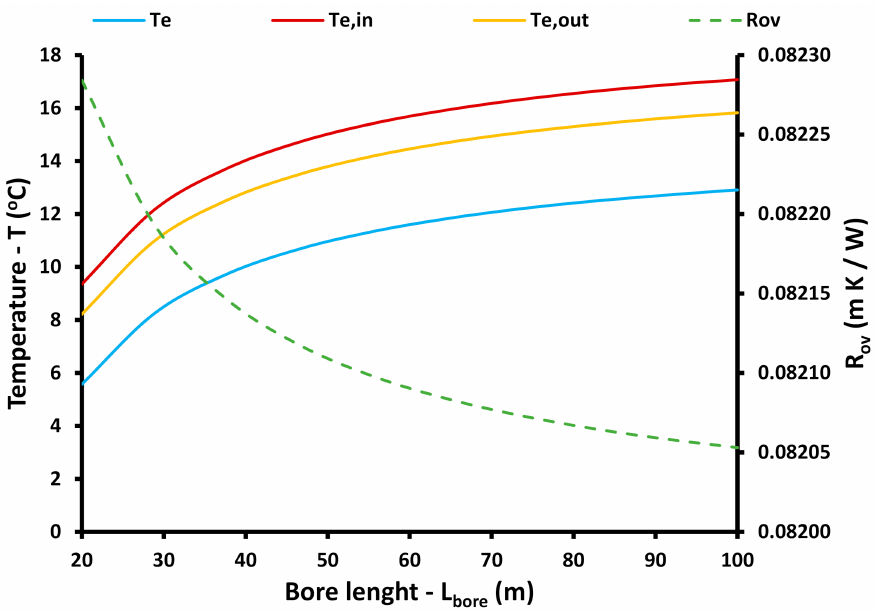
Figure 23. The impact of the borehole length on the evaporator temperature levels and on the overall